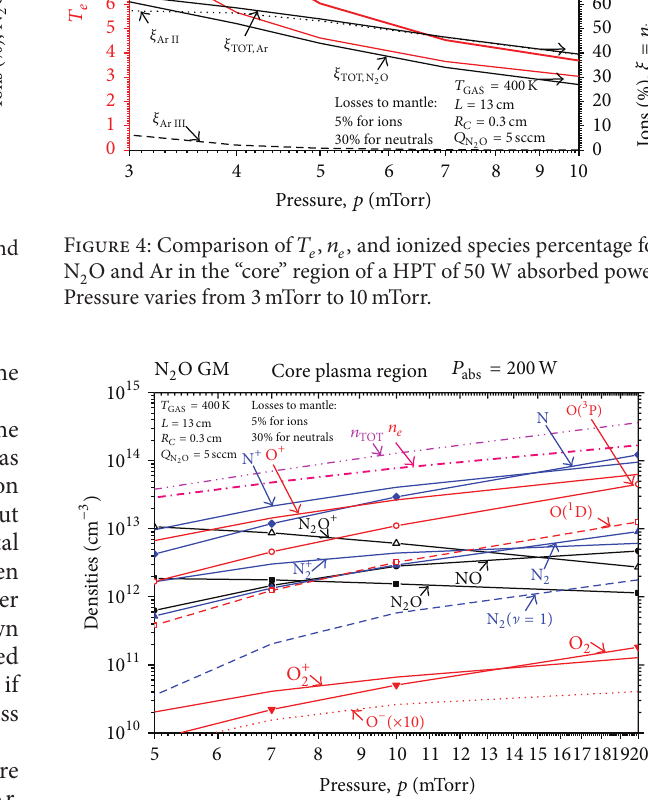
Figure5:“Core”regiondensitiesofspeciesofa5 sccmN 2 OfedHPT of 200W absorbed power. Pressure varies from 5mTorr to